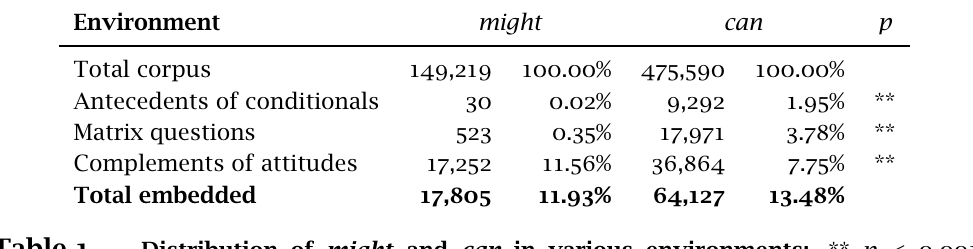
Distribution of might and can in various environments: ** p < 0 . 001 , Fisher’s exact test. Compares the distribution of might and can in each environment against their wider distribution in the